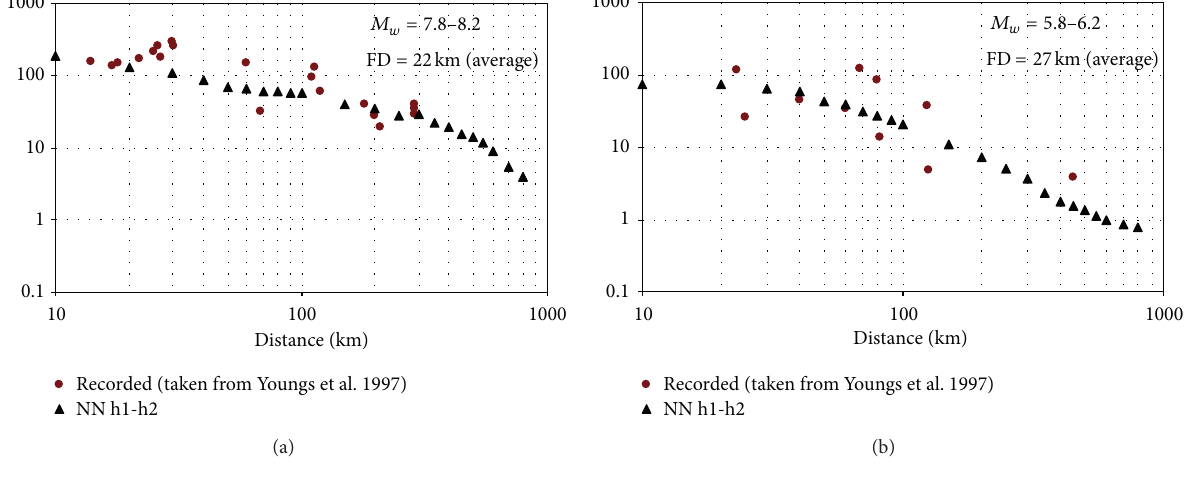
Figure 14: Comparison of NN model PGAh1-h2 with data published by Youngs et al. (1997)